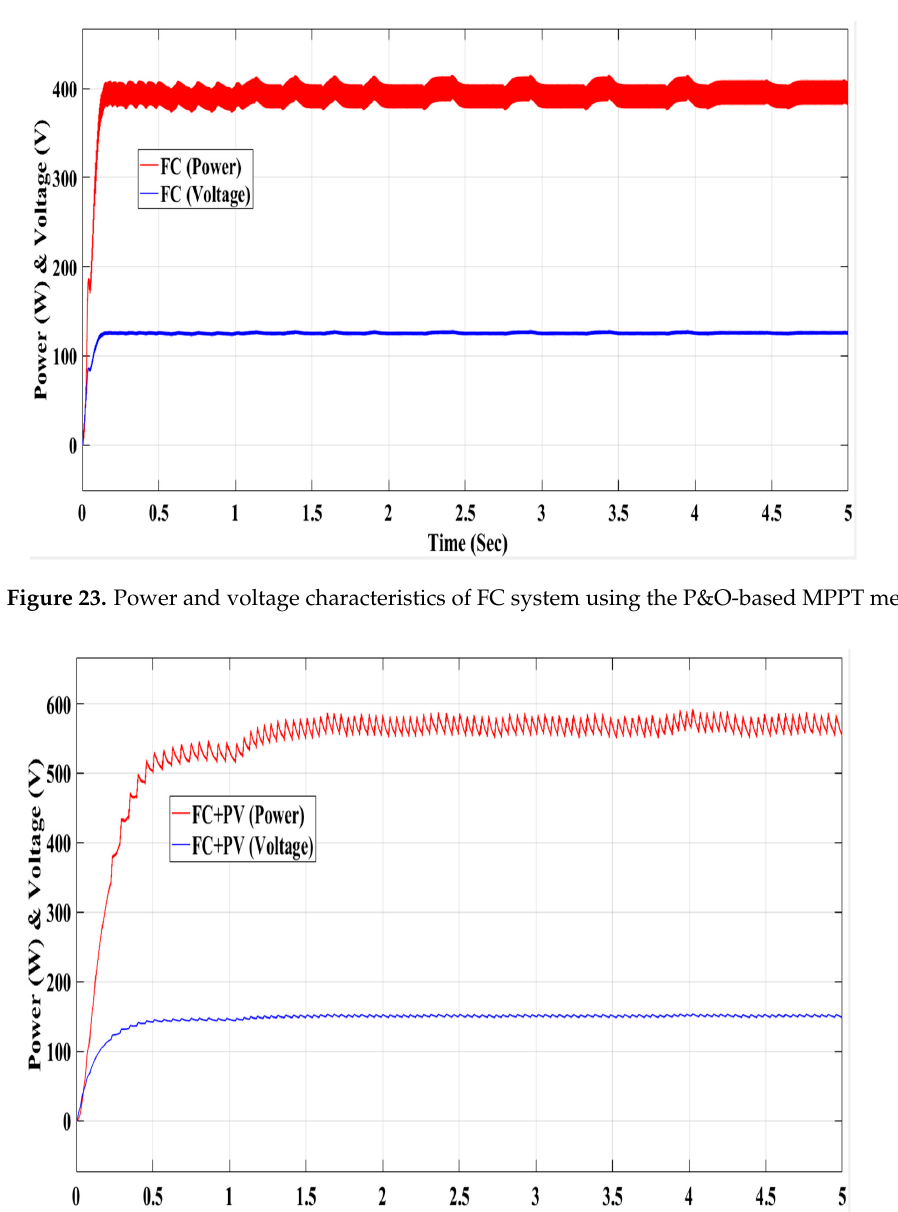
Figure 25. Power and voltage characteristics of the FC–W Model using the P&O-based MPPT method.